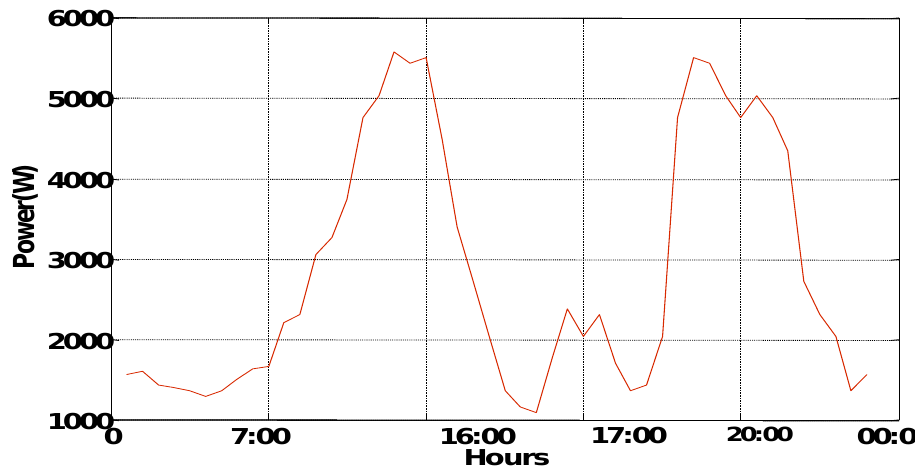
Figure 4. Consumption profile for atypical day. The solar irradiation profile is generated in a deterministic manner from the data, and measurements are done by the National Institute of Meteorology, using high-precision instruments to estimate solar irradiation. Figure 5 represents the power of solar irradiation given every half hour for (sampling time Ts) a typical site in Tunisia over a whole year.